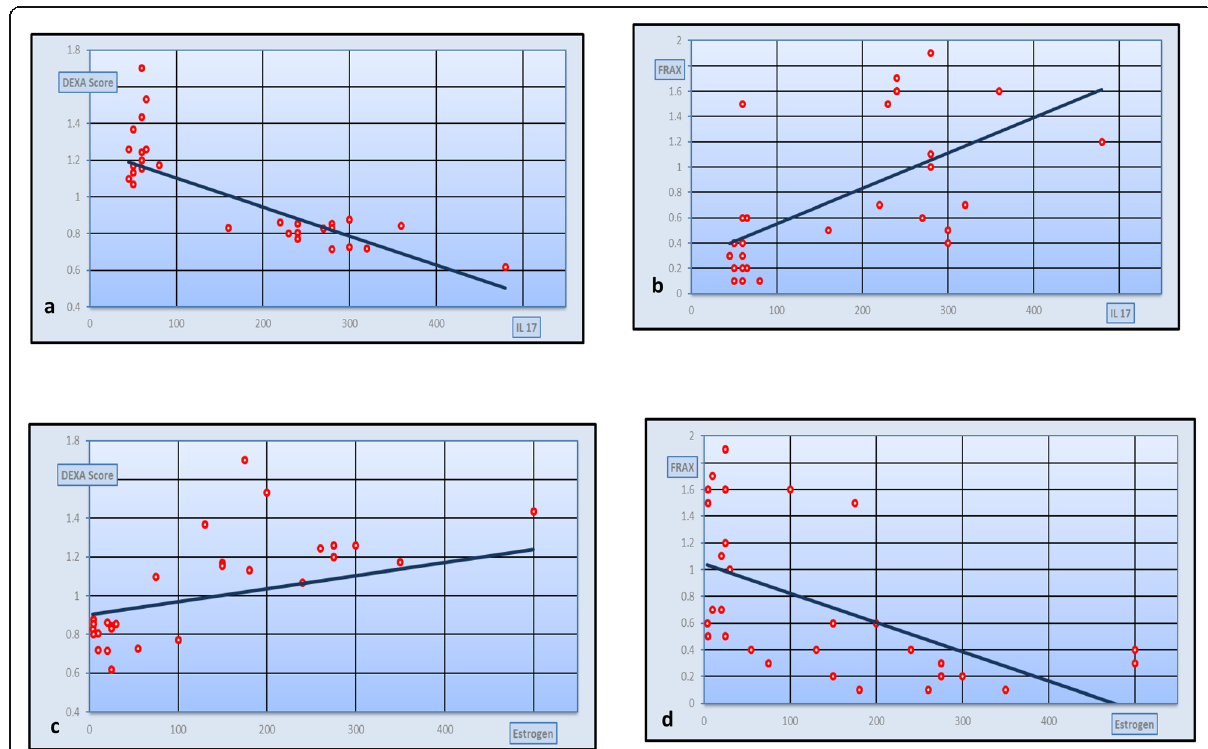
Fig. 1 Correlation study of IL-17 with DEXA score ( a ) and FRAX index ( b ). Correlation study of E2 with DEXA score ( c ) and FRAX index ( d